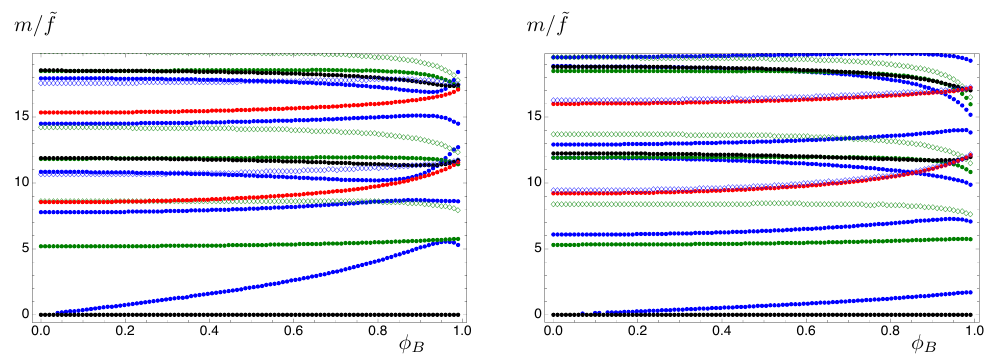
Figure 14 . Model IIA. Spectrum as a function of φ A for ∆ = 3 , ∆ φ = 1 , g 5 = 5 , ρ 1 = − 13 , ρ 2 = 8 , and x = 0 . 5 (left), x = 1 . 5 (right), normalized to the decay constant ˜ f ≡ f/ F F coding for the spectrum is: singlet scalar (blue), non-singlet scalar (blue diamonds), tensor (red), pseudoscalar (black), vector (green), axial-vector (green diamonds).